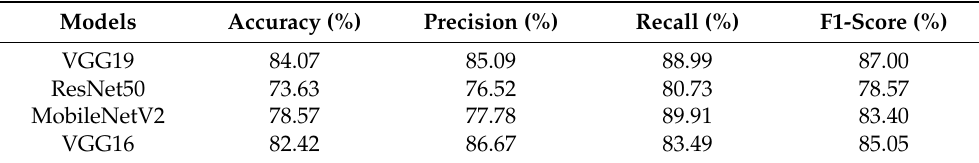
Table 7. Models with transfer learning from ImageNet for disc state classification without ROI and with fine-tuning.